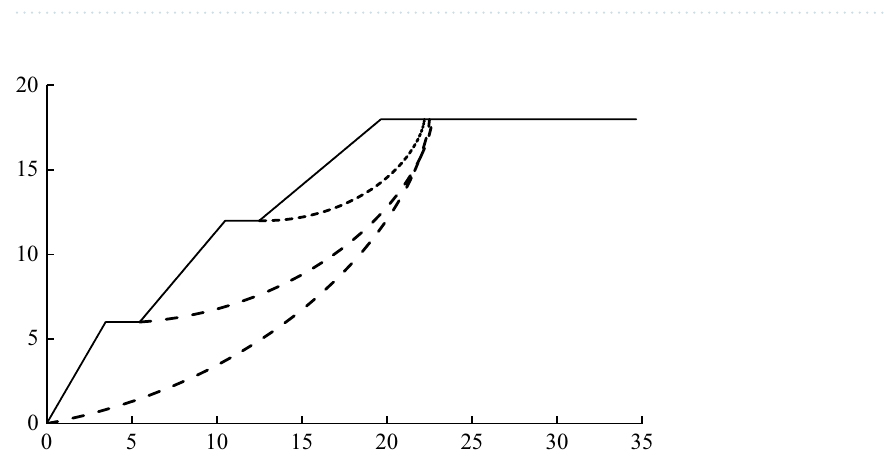
Table 1. Material parameters of calculation examples.